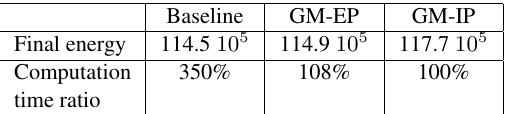
Table 1: The GM-EP algorithm obtains a lower energy than GM- IP for a slightly longer processing time. The Baseline obtains the lowest energy with a significant gap compared to GM-IP, but is more than 3 times slower on an Intel Xeon 8 core CPU computer (the code is not optimized). Therefore, the GM-EP algorithm de- fines good compromise between effective optimization and com- putation time.